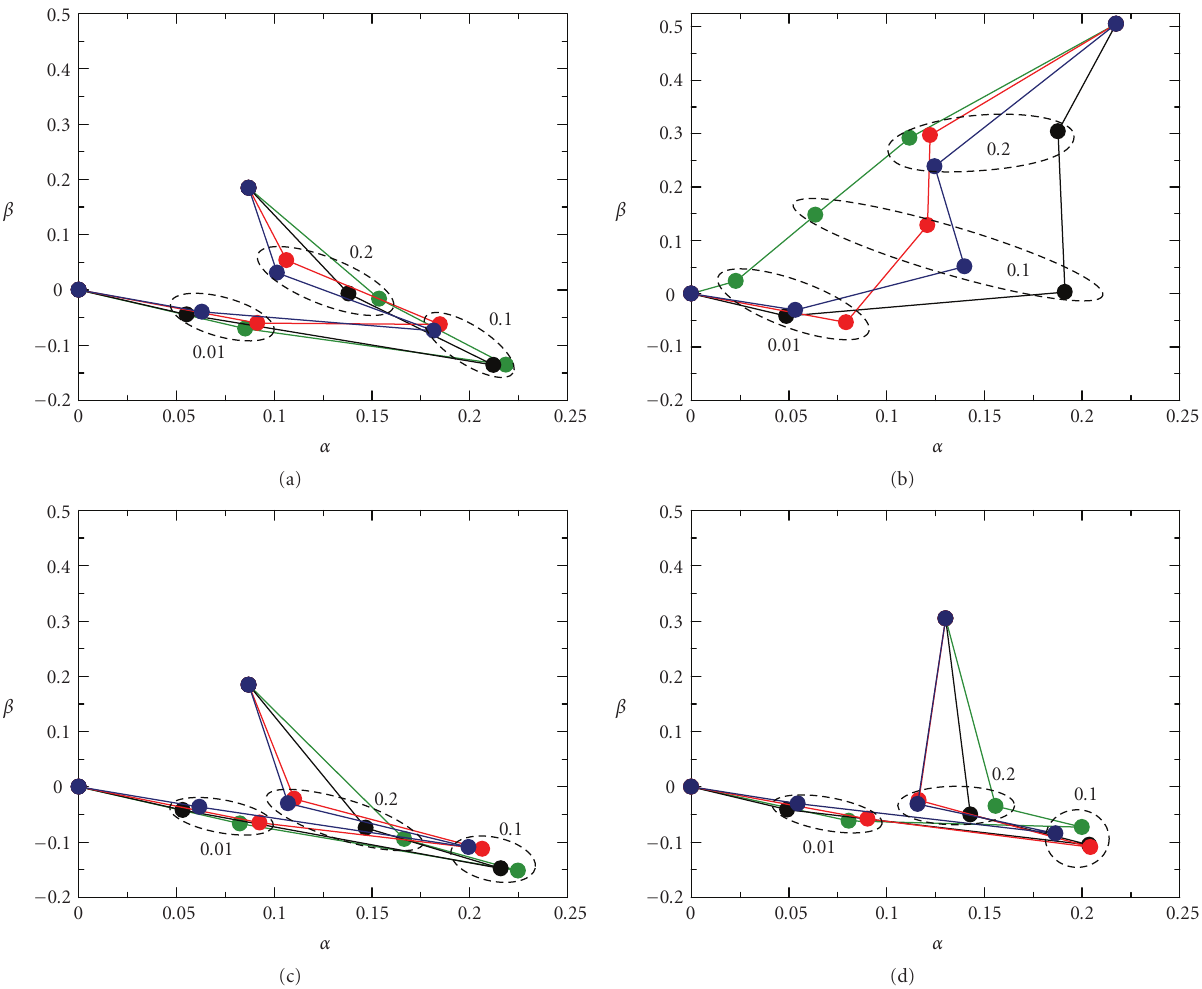
(c) Figure 6: 2D-Diagram of fluorescence spectra of binary-constituent lipid monolayers. Each point on the ( α , β ) plane represents a fluorescence spectrum of a BODIPY-labeled binary-constituent lipid monolayer. For the j th spectrum α = V j 1 and β = V j 2 , where V j 1 and V j 2 are j th component of the 1st and 2nd eigenvectors, respectively. A zig-zag line of the same color connects points belonging to monolayers comprised of the same lipid constituents. These lines start from the origin representing the spectra of di ff erent monolayers with 0 of the monolayer increases with successive dots corresponding to Me 4 BODIPY-PC mole fractions of 0.01, 0.1, and 0.2. All lines converge to the same final point, representing the spectrum of pure Me 4 BODIPY-PC monolayer. Panels (a) and (b) represent lateral pressures of 5 and 30mN/m; whereas, panels (c) and (d) correspond to average cross-sectional molecular areas of 75 and 64 ˚A 2 /molecule, respectively. Color codes: Me 4 BODIPY-PC/POPC (black), Me 4 BODIPY-PC/DPPC (green), Me 4 BODIPY-PC/18:1SM (blue), Me 4 BODIPY-PC/16:0SM (red). The dotted ellipses encircle equivalent Me 4 BODIPY-PC mole fractions, with the numerical label indicating the fluorophore mole fraction (0.01, 0.1, or 0.2) mixed with each of the four di ff erent nonfluorescent lipids (POPC, DPPC, 18:1-SM, or